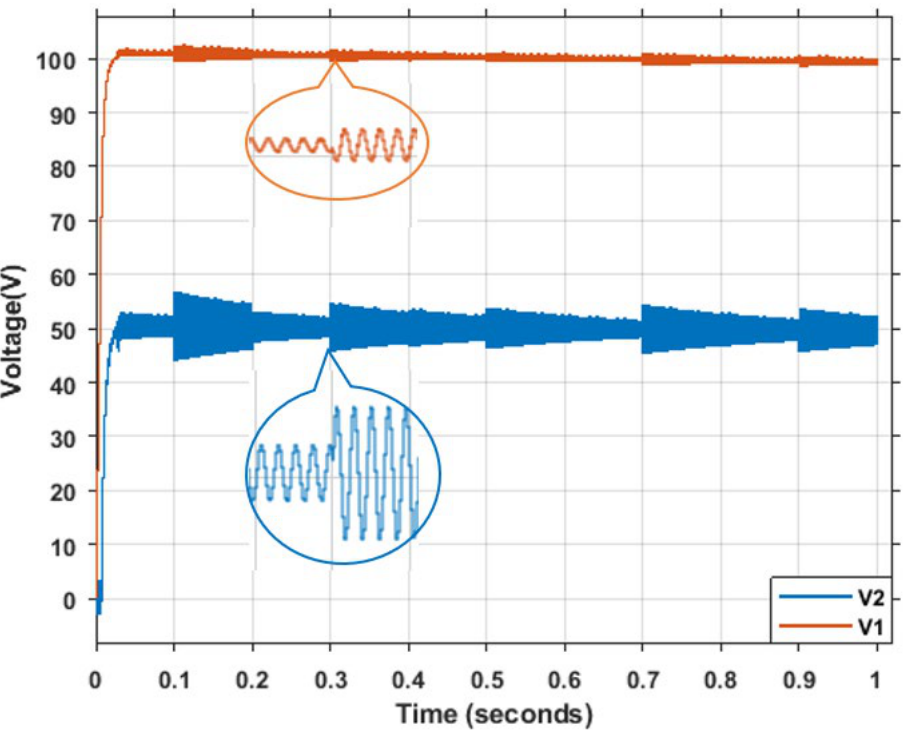
Figure 12. DCSOP terminal voltages as a result of a repeated and very aggressive step change in power flow direction.